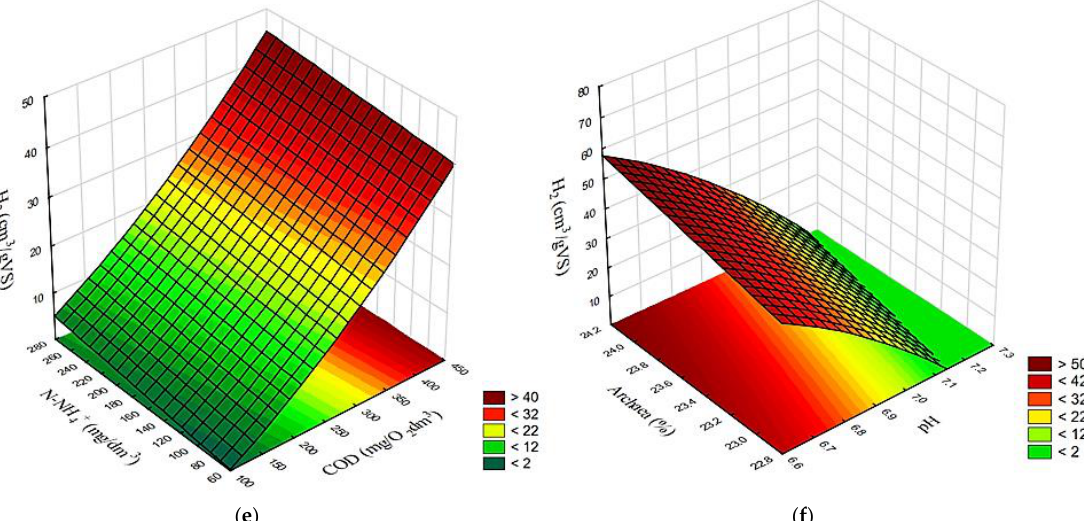
( f ) Figure 10. Surface correlation between concentrations of COD and N-NH 4, as well as pH and Archaea percentage, and yields of ( a , b ) biogas; ( c , d ) CH 4 ; as well as ( e , f ) H 2 , respectively. The multiple regression method was deployed to develop empirical equations for estimating production yields of biogas, CH 4 , and H 2 . Only variants V1 – V4 were considered in the estimation due to linear correlation. It was found that biogas and methane yields were statistically significantly affected by such predictors as COD concentration in the dissolved phase and the SCO 2 /AGS volume ratio. The postulated model of biogas yield (1) is characterized by an estimation error of ±1.5157 and reflects ca. 98.99% of changes in the process of biogas production (R 2 = 0.9899). The CH 4 yield model (2) reflects ca. 98.74% changes in the process of its production, with a coefficient of determination at R 2 = 0.9874 and an estimation error of ±6.5299. In turn, the empirical model of H 2 production (3) has a coefficient of determination at R 2 = 0.9979 and an estimation error of ±0.7867.